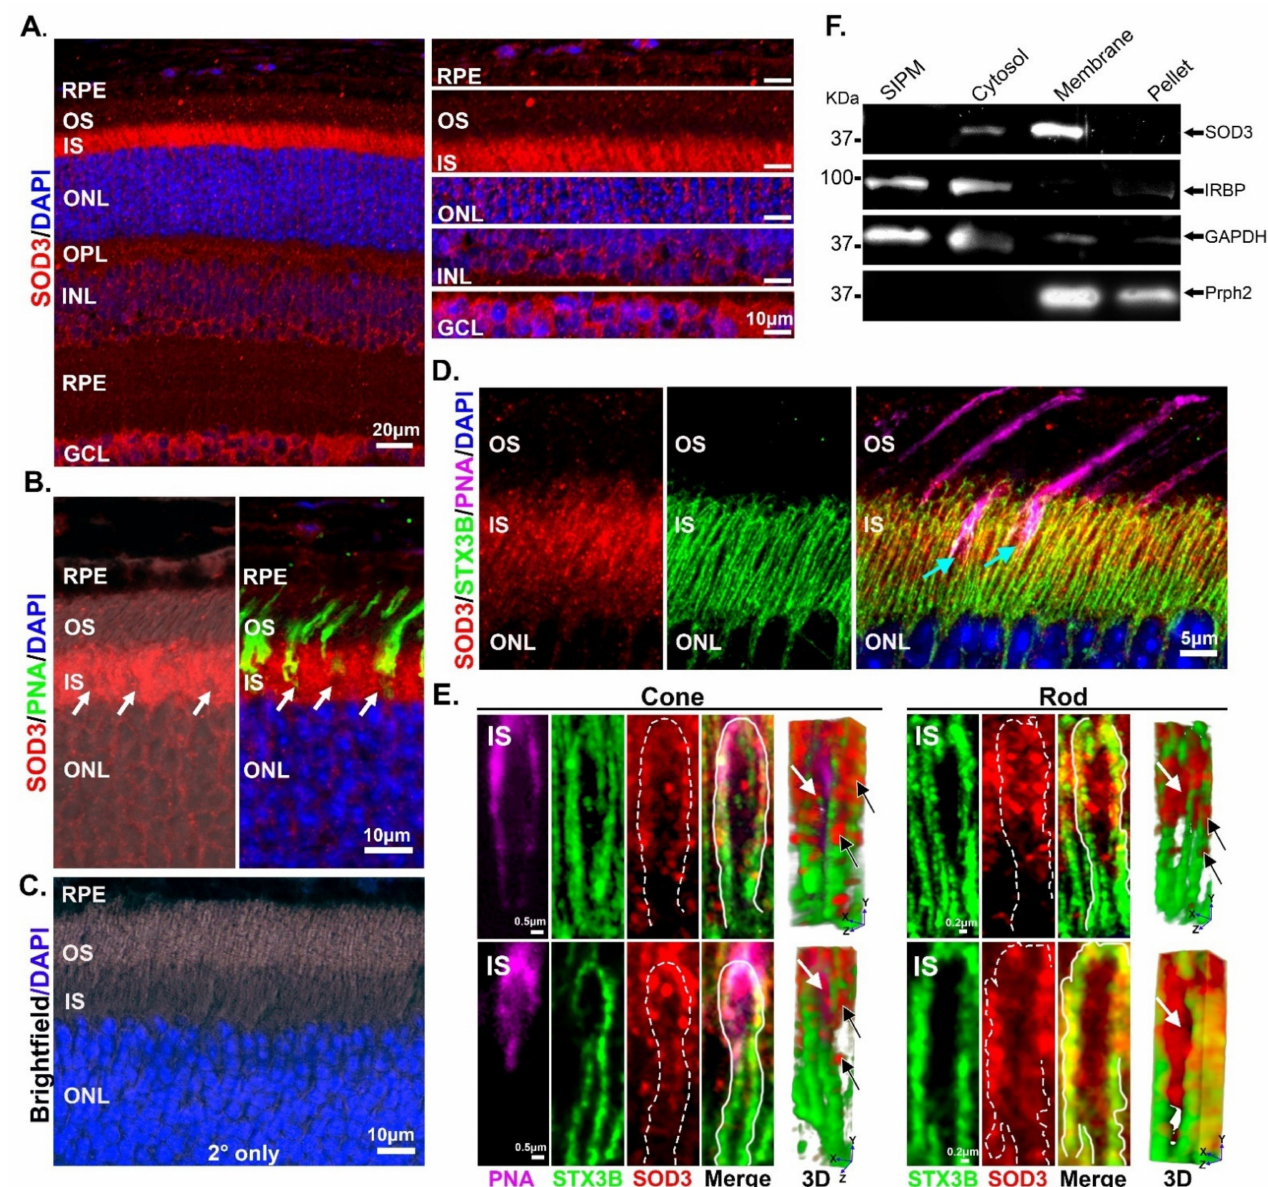
Figure 2. Intracellular and extracellular distribution of retinal SOD3. Immunofluorescence and fractionation experiments were performed. ( A ) Labeling with anti-SOD3 at 20 × (with 1.3 × zoom) indicates ubiquitous expression of the protein throughout the retina. Regional images were extracted from the 20 × image to evaluate staining throughout the retinal strata. ( B ) Higher magnification imaging (40 × with 2 × zoom) demonstrates that the majority of SOD3 is found in the IS, though smaller amount is also present in RPE, OS, and around photoreceptor nuclei. White arrows point to areas of low SOD3 staining. Labeling with PNA show that these low-signal areas are cones (right image). ( C ) A secondary-only control, captured at 63 × , demonstrates lack of non-specific signal. ( D , E ) Labeling with anti-STX3B and PNA reveal the extracellular and intracellular localization of SOD3 in rod and cone inner segments. Light blue arrows point to co-localization of STX3B and PNA to differentiate cone photoreceptors from rod photoreceptors. White arrows indicate intracellular SOD3 while black arrows indicate areas of colocalization of SOD3 and STX3B and extracellular localization of SOD3. Dashed lines/white lines delimit the IS membrane marked by STX3B labeling. (Scale bar in ( A ) is 20 µ m, 10 µ m in ( B ), 10 µ m in ( C ), and 0.5 and 0.2 µ m, respectively, in the bottom panels of ( D , E ). ( F ) Cellular fractionation confirms the localization of SOD3 in the cytosol and the membrane/insoluble